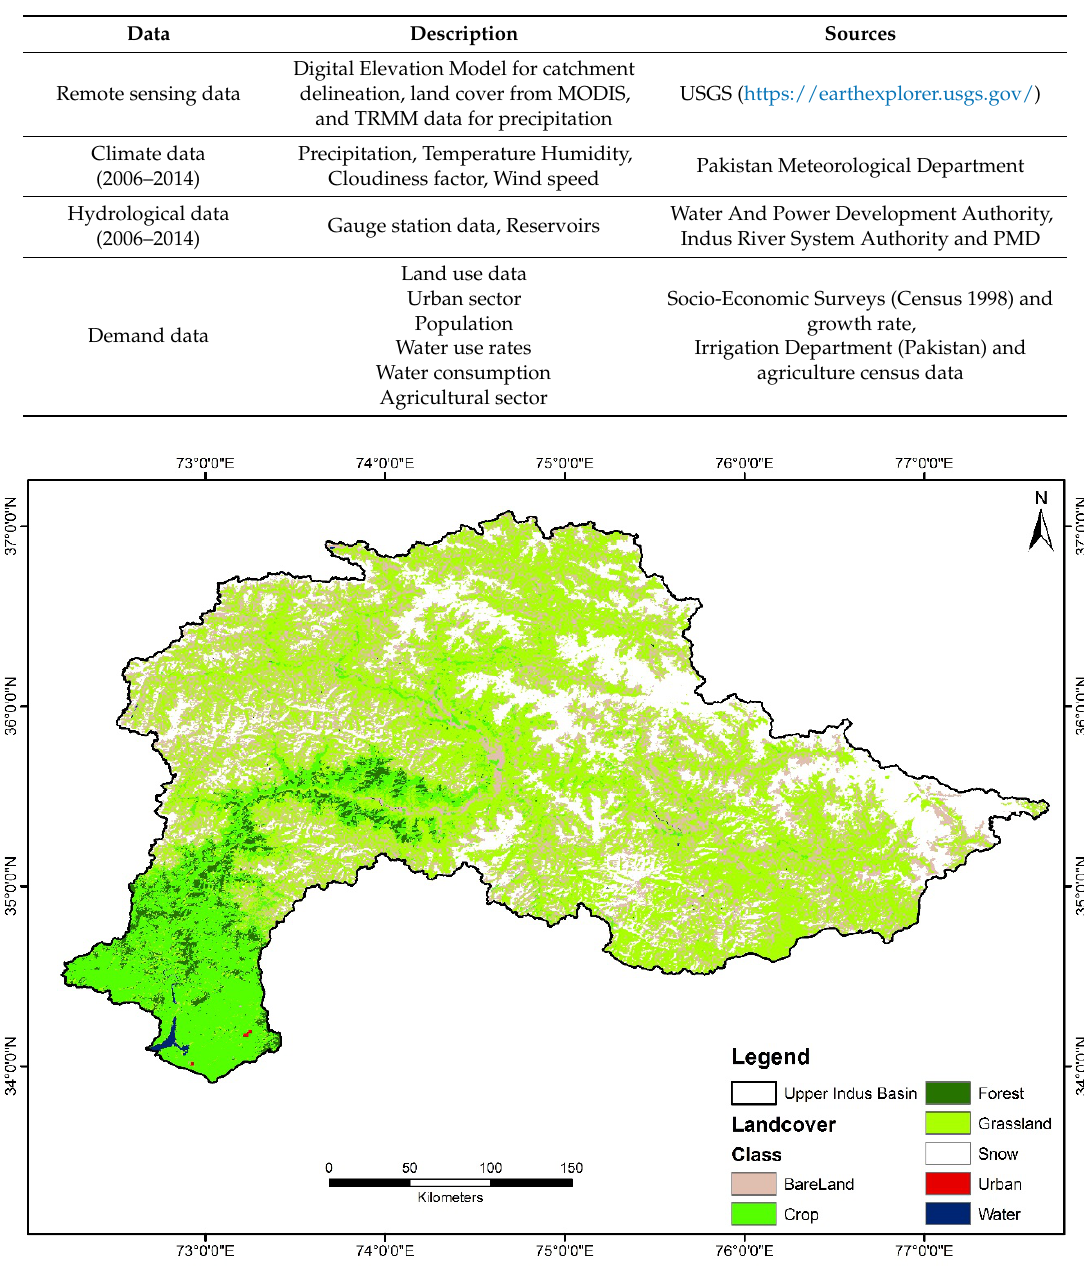
Figure 2. The land cover/use map of the Upper Indus Basin derived from the MODIS land cover data.